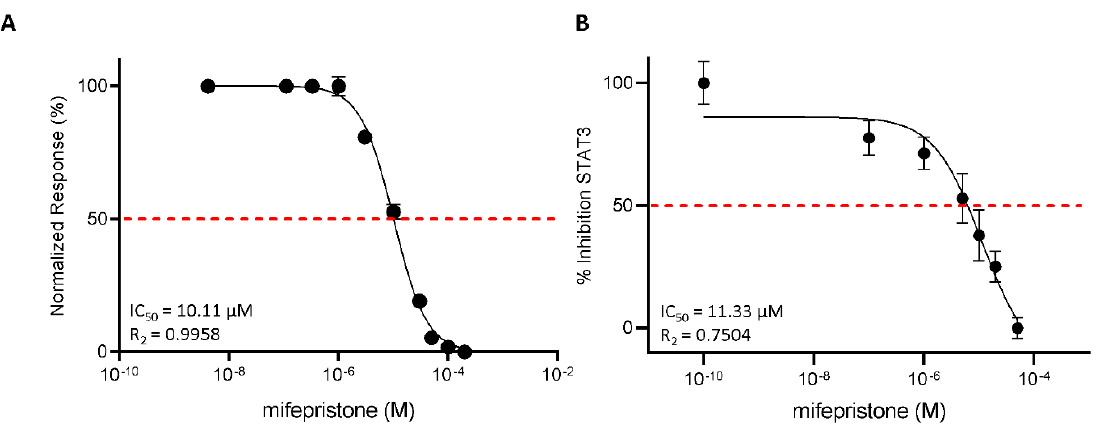
Figure 5. Mifepristone antagonizes LIFR and reduces STAT3 activation. ( A ) Mifepristone inhibition activity of LIFR/LIF binding accessed by a cell-free AlphaScreen assay. ( B ) STAT3 transactivation on HepG2 cells. Results are expressed as mean ± SEM of five samples per group.